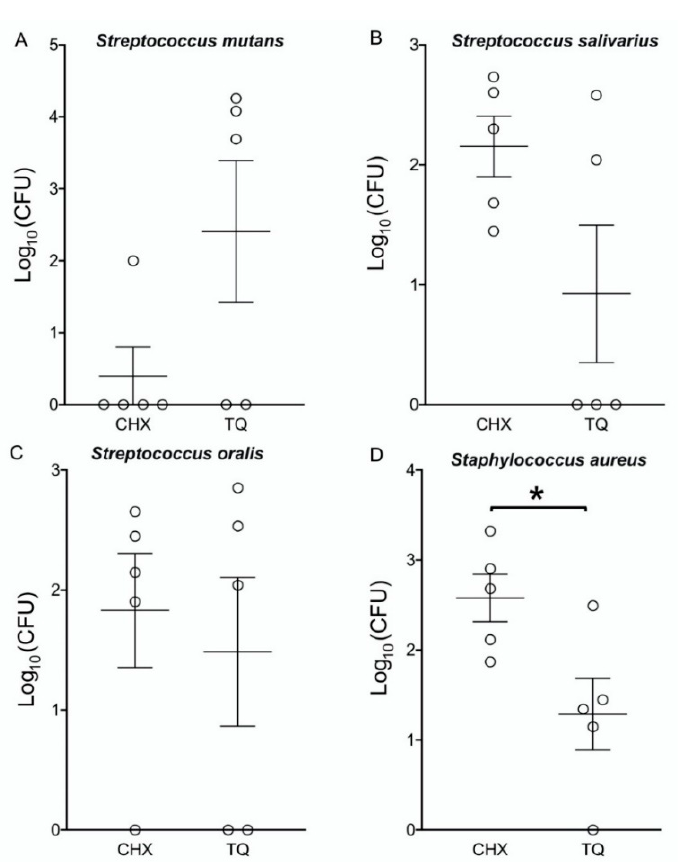
Figure 2. Viable bacterial count using Log10 transformation for CHX (chlorohexidine) TQ (Thymo- quinone). * Statistically significant difference at ( p < 0.05)